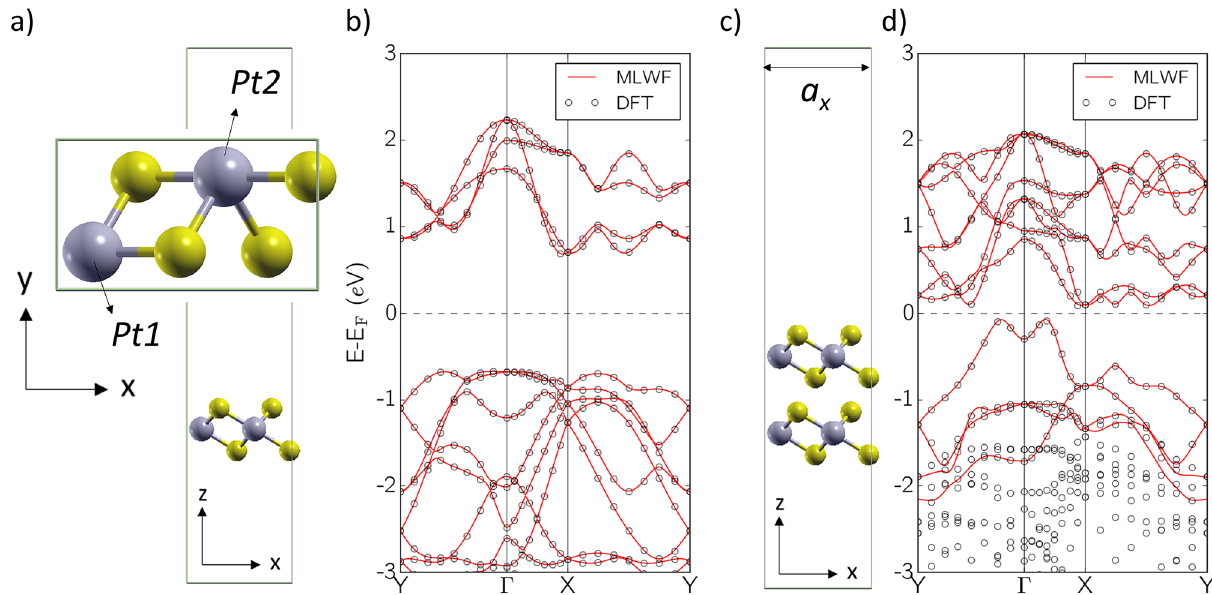
Figure 2. DFT models. ( a ) Unit cell and ( b ) DFT and Wannier interpolated bands for bulk 1L PtSe 2 , with Pt in grey and Se in yellow. The inset shows the cell from the top. ( c ) Unit cell and ( d ) DFT and Wannier interpolated bands for bulk 2L PtSe 2 . This figure was made using VMD [v1.9.1, https:// www. ks. uiuc. edu/ Resea rch/ vmd/ vmd- 1. 9.1] and Matplotlib [v3.3.3, https:// doi. org/ 10. 5281/ zenodo. 42689